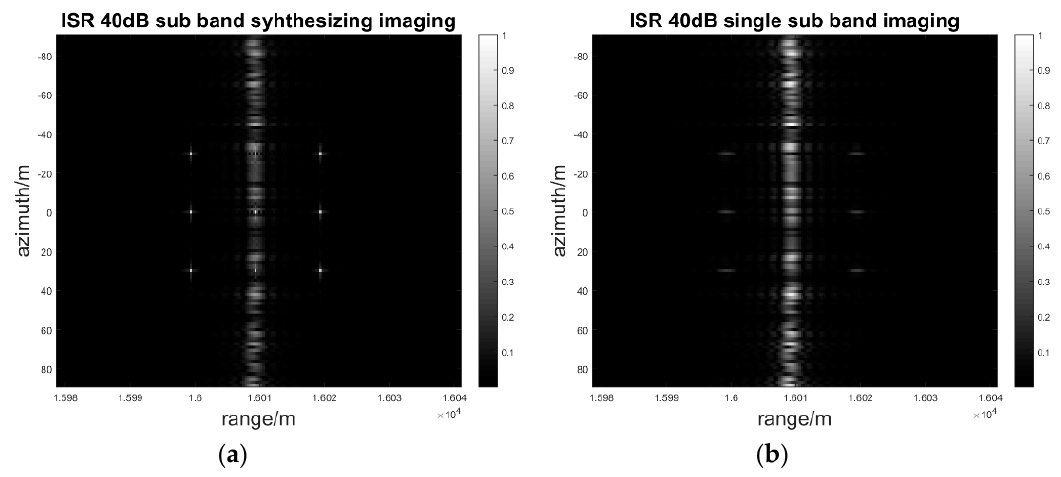
Figure 14. ISR 40 dB sub-band synthesis and single sub-band imaging result: ( a ) Sub-band synthesis of a two-dimensional gray image; ( b ) Single sub-band synthesis of a two-dimensional gray image. Table 2. The quantitative results for retransmitting deception jamming suppression. ISR (dB) SIR 2 1 SIR 1 2 r A 2 3